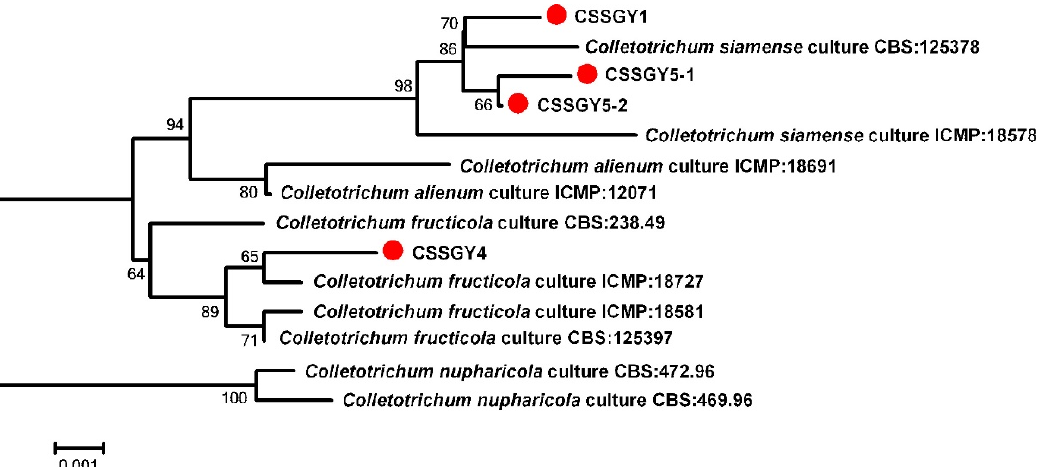
Figure 3. Construction of a phylogenetic tree based on concatenated sequences of the internal tran- scribed spacer (ITS), actin ( ACT ), chitin synthase ( CHS-1 ), glyceraldehyde-3-phosphate dehydro- genase ( GAPDH ), β-tubulin ( TUB2 ), and partial mating type (Mat1-2) gene ( ApMAT ) regions, using the neighbor-joining method. Notes in the branches indicate the bootstrap values supporting the branches that were calculated from the bootstrap test of 1000 replicates. The isolates CSSGY1, CSSGY4, CSSGY5-1, and CSSGY5-2 were marked with red dots. The scale bar indicates the number of substitutions at each position. The sequence information of the Colletotrichum species used for phylogenetic analysis is shown in Table 3.